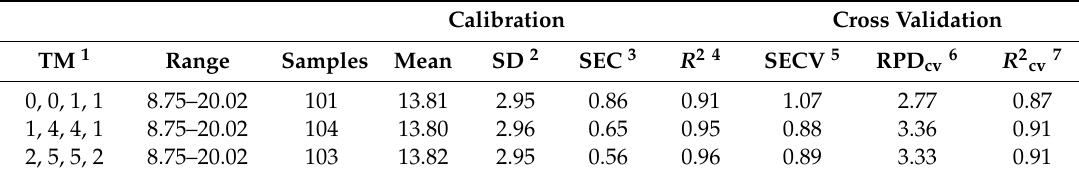
Table 3. Calibration and cross validation statistics for ADF content in Brassica rapa .